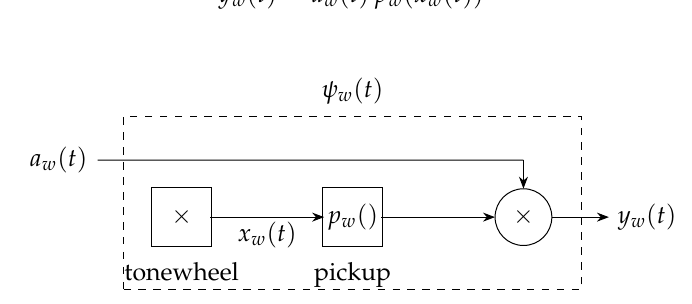
Figure 2. One tonewheel